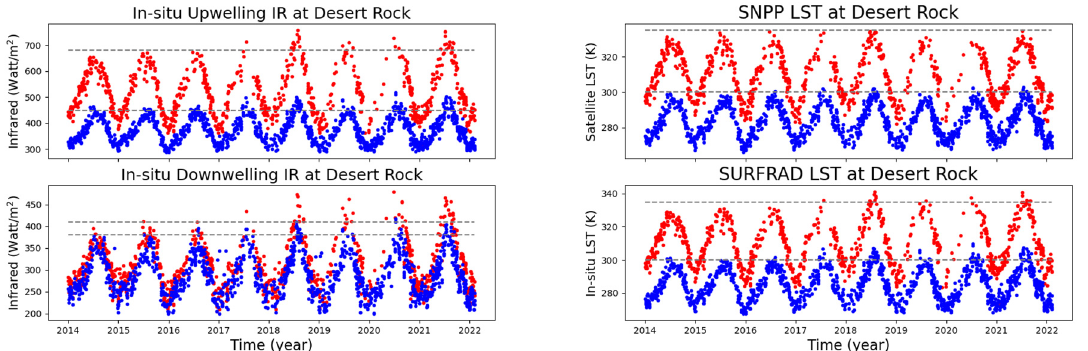
Figure 5. The time series of in situ radiation ( left ) with upwelling IR ( top left ) and downwelling IT ( bottom left ), satellite LST ( top right ), and ground LST ( bottom right ( bottom left ), satellite LST ( top right ), and ground LST ( bottom right ).